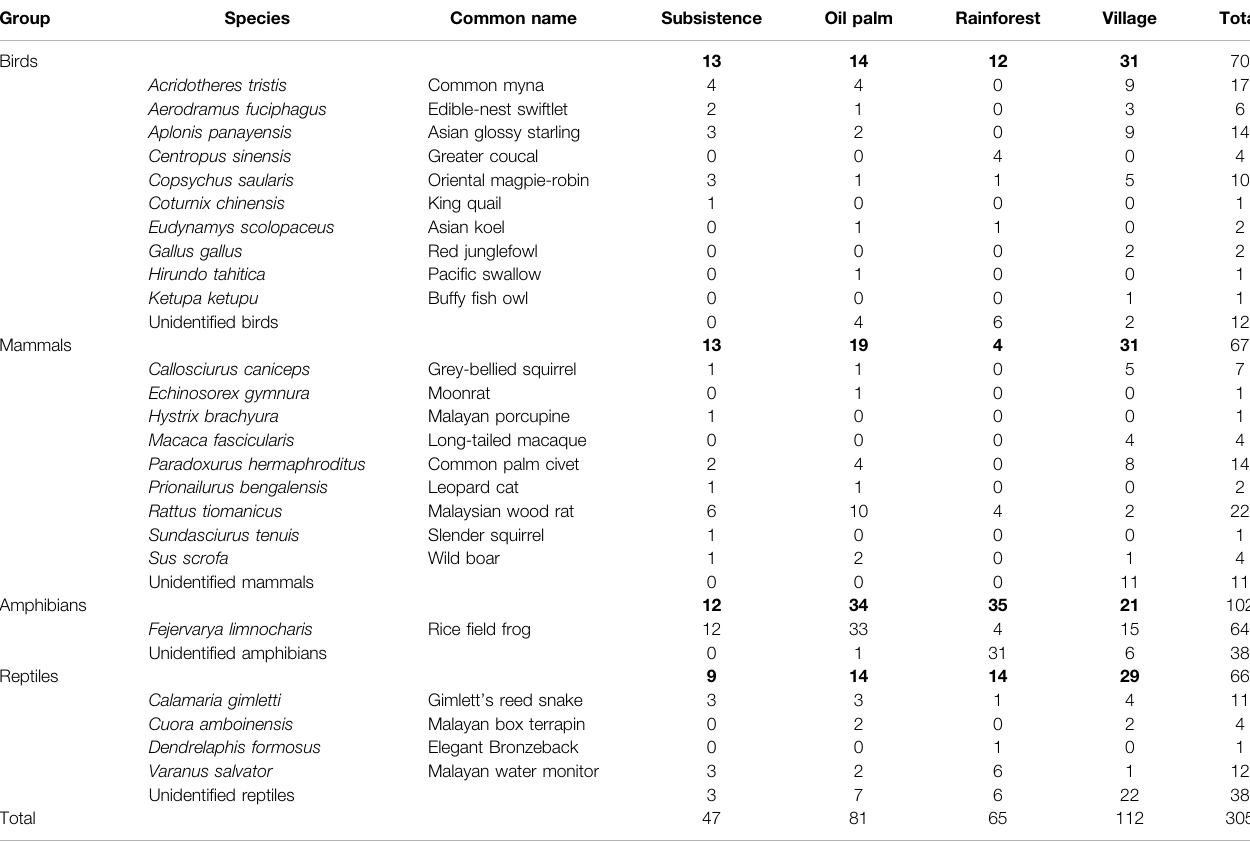
TABLE 1 | Vertebrate roadkills found in the road segments listed by number of individuals per taxonomic group, species, and habitat type. A number of roadkills were unidenti fi able because carcasses were too degraded. Bold values signi fi es “ Total values ” . Group